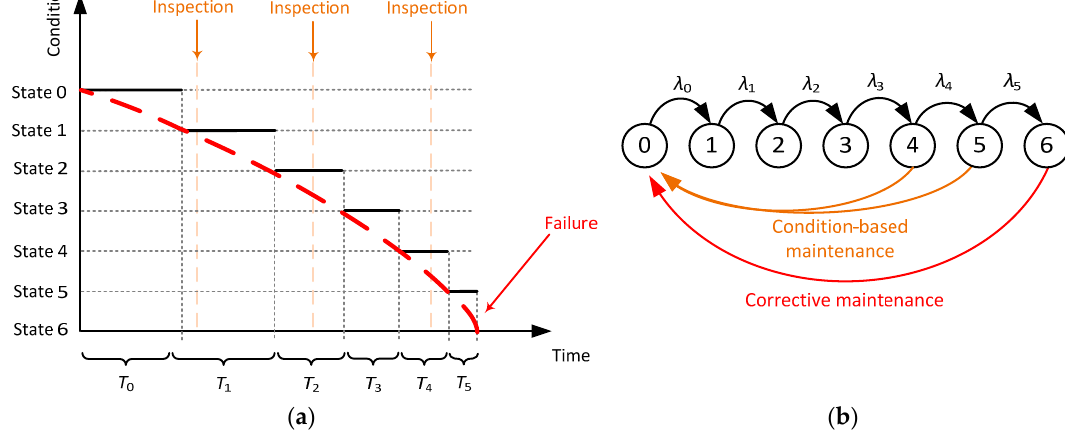
Figure 1. Illustration of a degradation process modelled as a continuous-time Markov process: ( a ) degradation process, condition states and inspection strategy; ( b ) the Markov process and maintenance strategy.